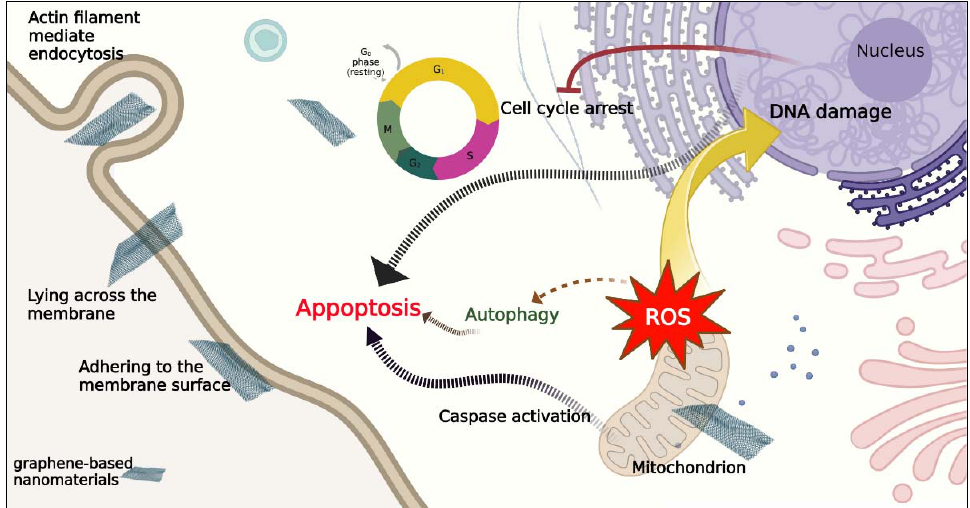
Figure 6. Schematic model to illustrate the proposed mechanism of cell death induced by graphene- based nanomaterials on oxidative stress, apoptosis, cell cycle, and autophagy in breast cancer cells, based on recent studies [151–153].